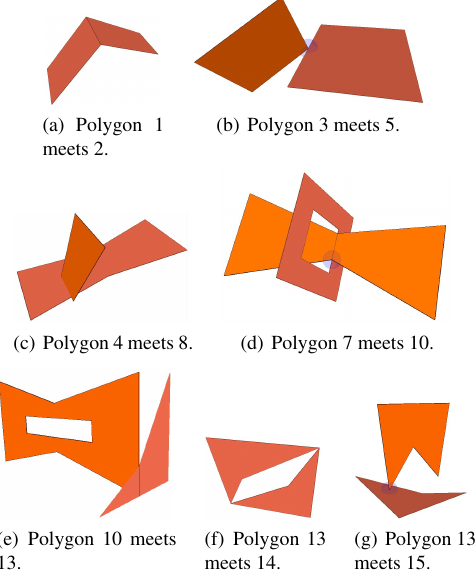
Figure 12: Polygon pairs whose topological relationships are cal- culated as ’meet’.